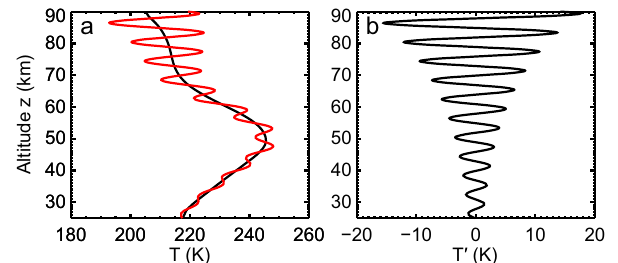
Figure 1. (a) Background temperature profile T 0 used for the sim- ulations (black) and perturbed temperature profile T (red). (b) The temperature perturbations T (cid:48) added to T 0 . Temperature perturba- tions in both panels were constructed using Eq. (6) with the fol- lowing set of parameters: t = 4h, A = 1.2K, λ z = 6km, τ = 1.9h, H = 12km.